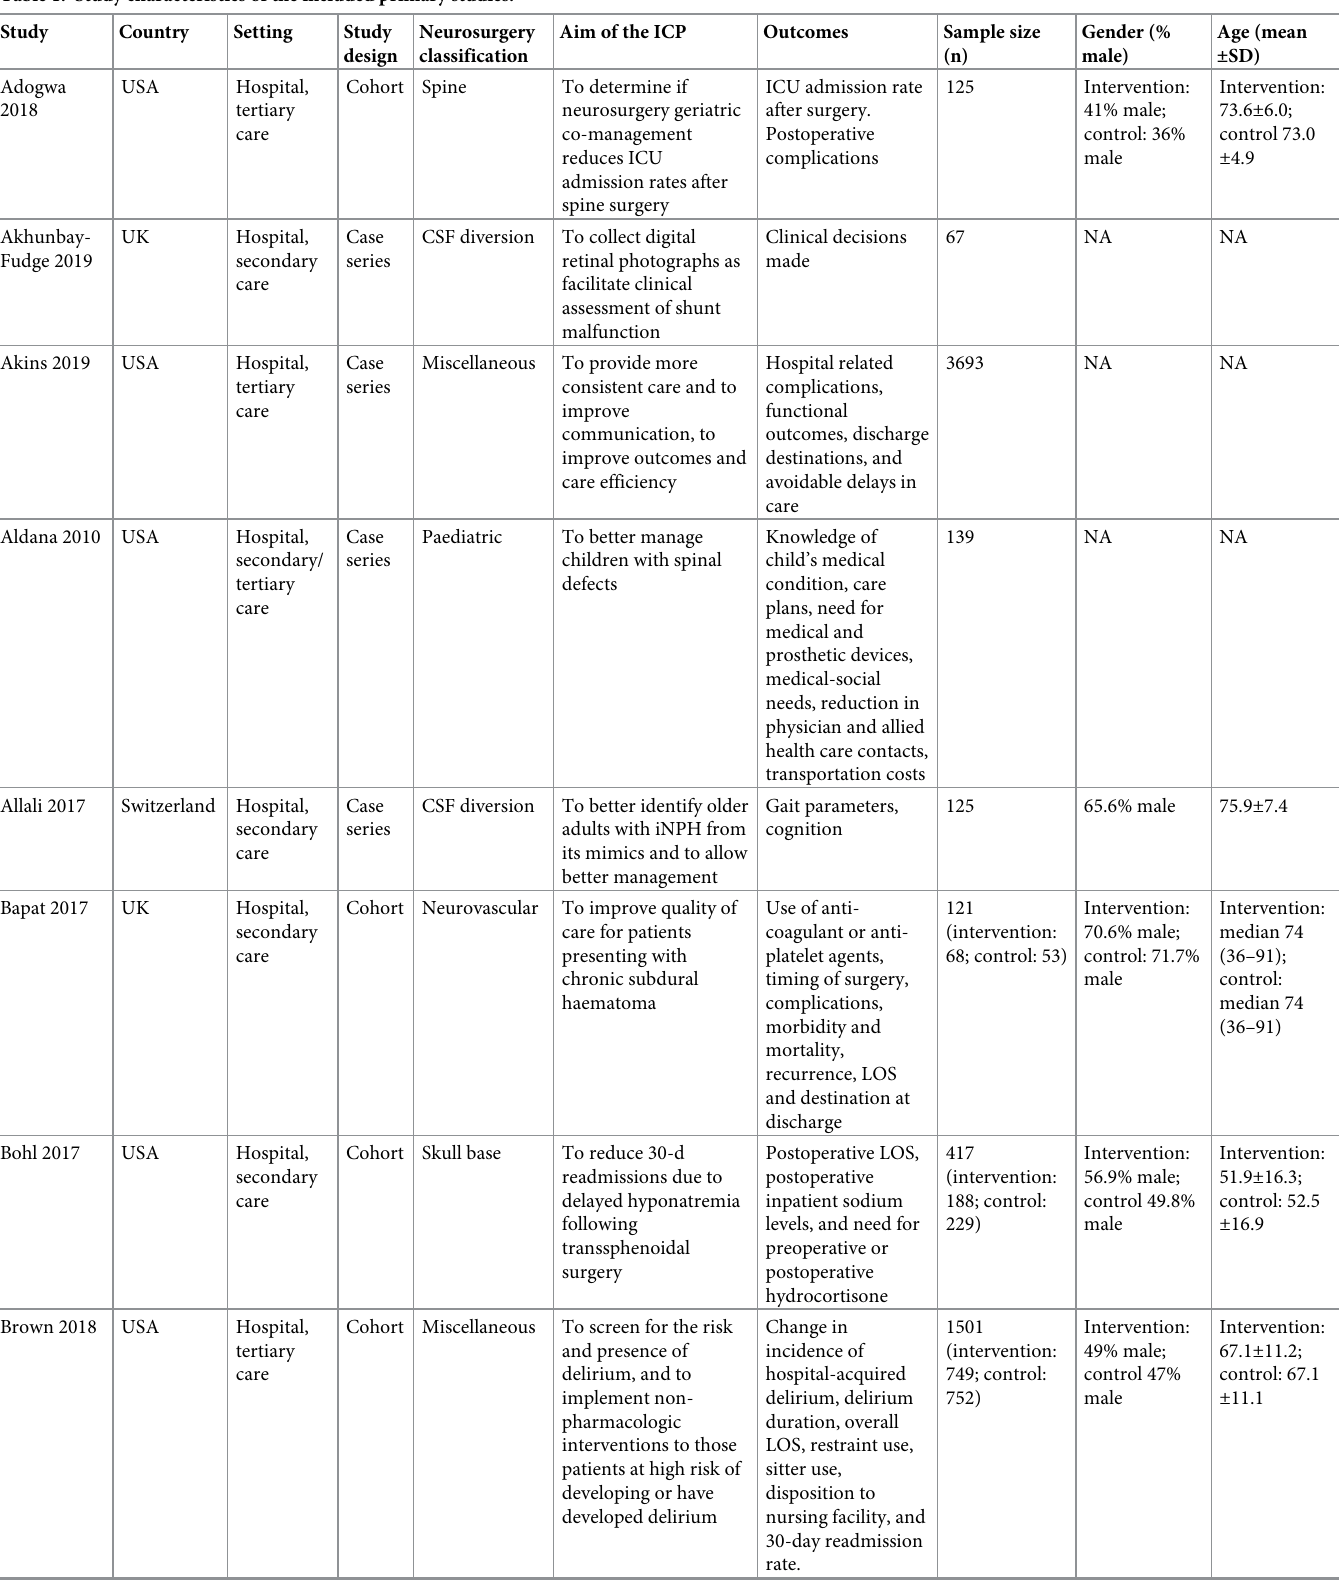
Table 1. Study characteristics of the included primary